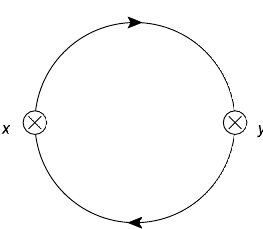
Figure 3. Leading order diagram for the gradient-(cid:13)ow evolved 2-point vector correlator. Lines are gradient-(cid:13)ow evolved propagators | see notation in appendix